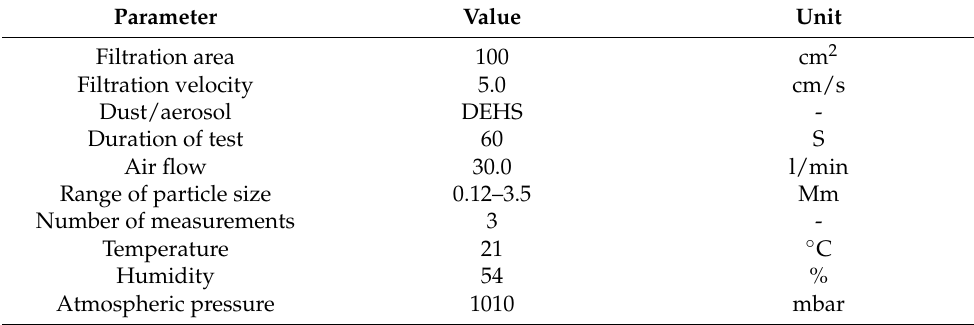
Table 3. Parameters of testing.